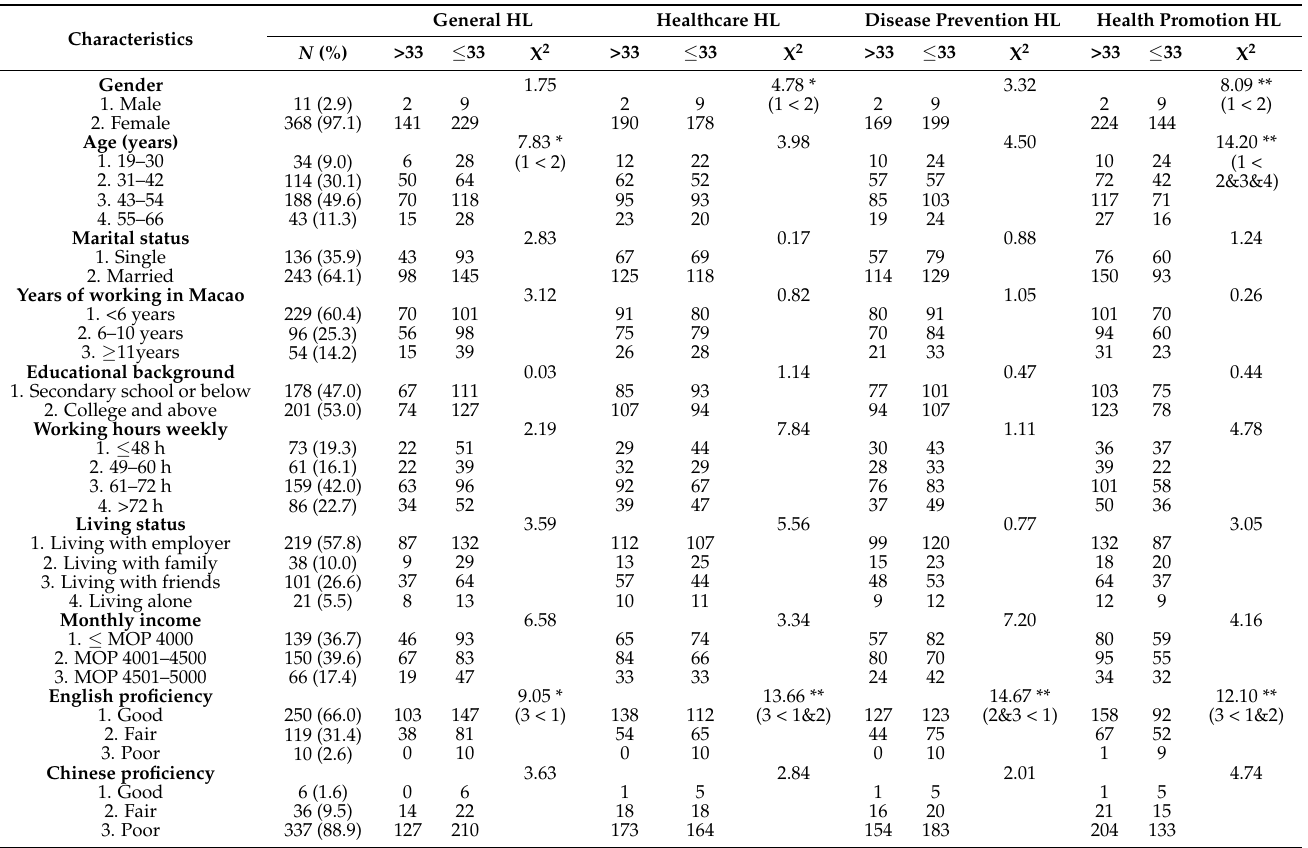
Table 1. Demographic Characteristics of respondents and the association to health literacy ( N =